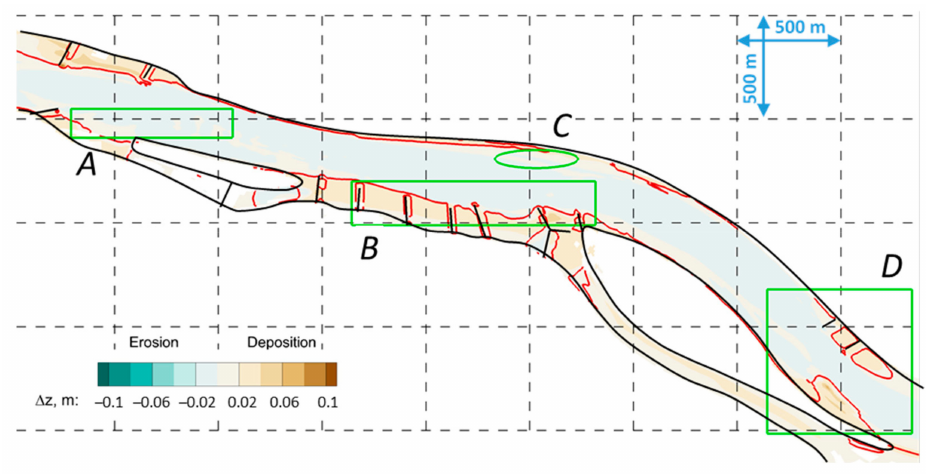
Figure 8. Calculated bed changes by the combined method for a 2.5 month-long period (Figure